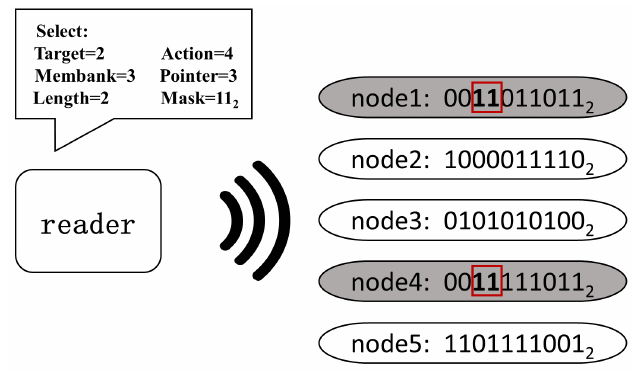
Figure 3. An example of